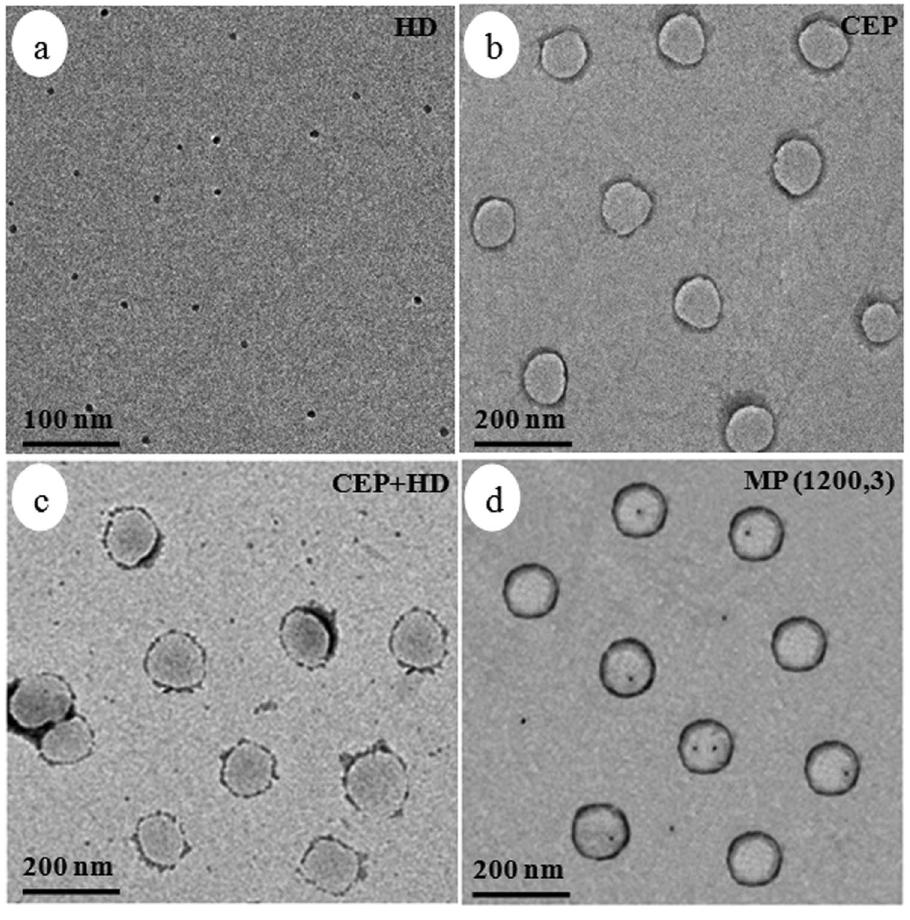
Figure 2. TEM images of HD ( a ) CEP ( b ) CEP + HD ( c ) MP(1200,3) ( d ). CEP denotes conventional emulsion polymerization, CEP + HD represents the emulsion containing HD synthesized by CEP, MP (1200, 3) signifies miniemulsion polymerization through homogenizer pressures of 1200 bar, and pass number of